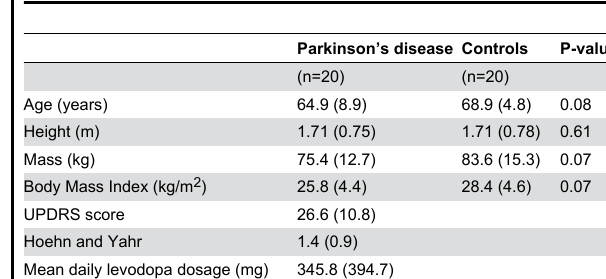
Table 1. Average (and SD) age, height, mass, body mass index (BMI) and clinical scores for the Parkinson's disease and control